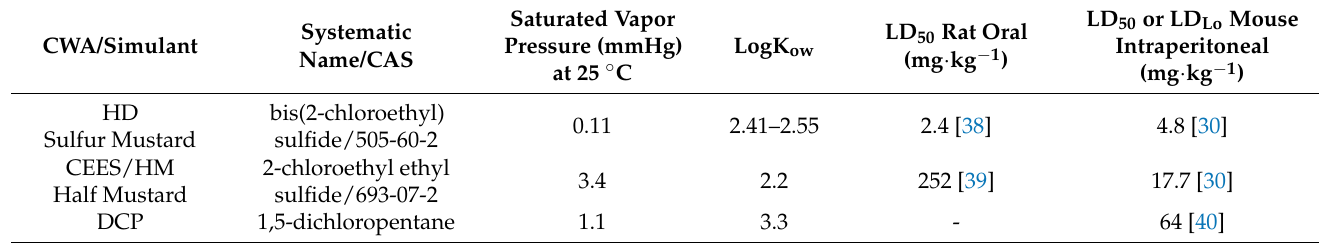
Table 1. Some physicochemical properties and toxicity of HD and its simulants (LD 50 stands for Lethal Dose 50; LD Lo stands for Lethal Dose